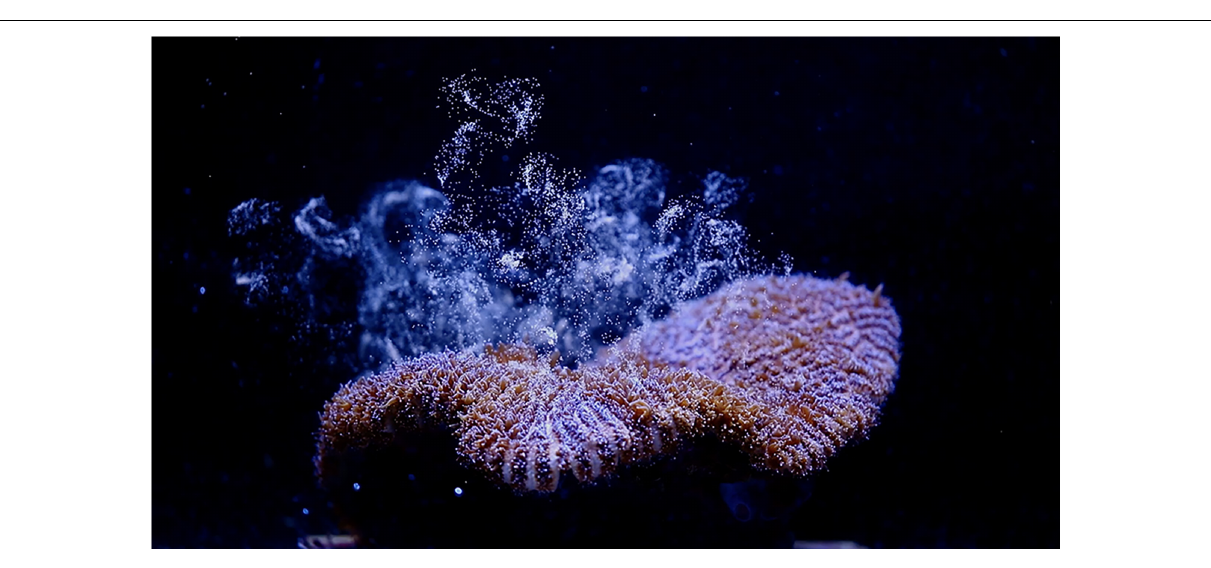
FIGURE 2 | Female D. cylindrus colony releasing eggs during the August 2019 ex situ induced spawning